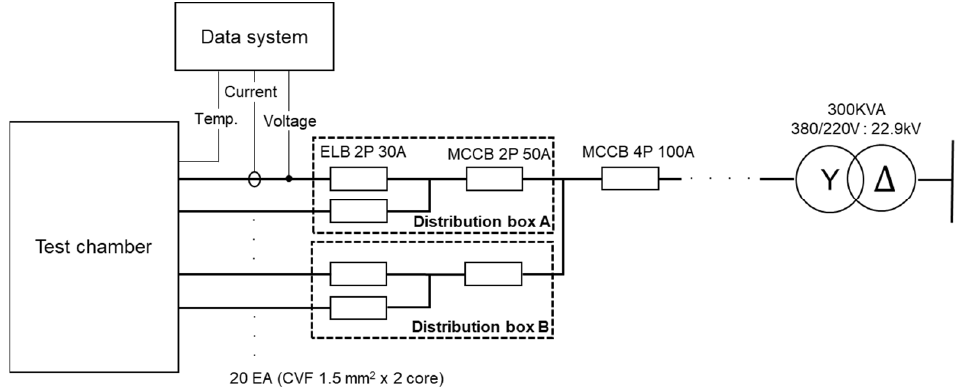
Figure 1. Single-wire line diagram of the experimental power supply. ELB: earth-leakage circuit breaker; MCCB: molded-case circuit breaker.